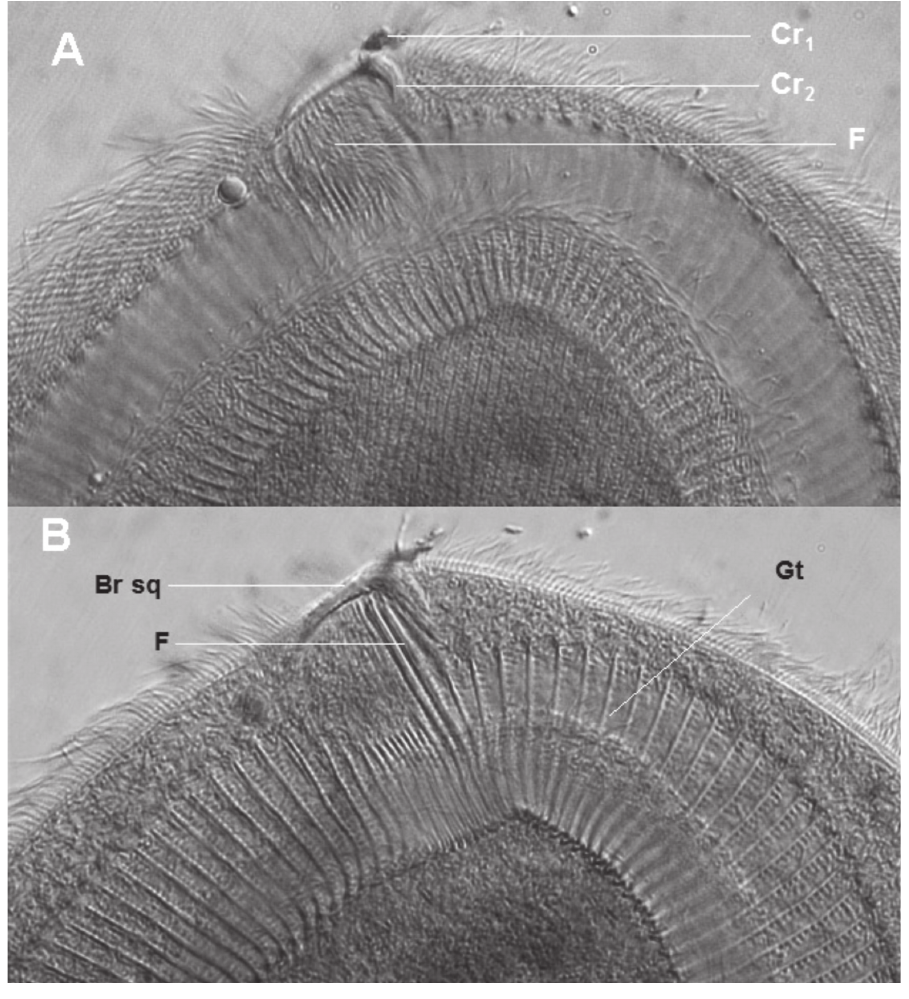
Figure 10. – Photographie de Dicoelophrya mediovacuolata n.